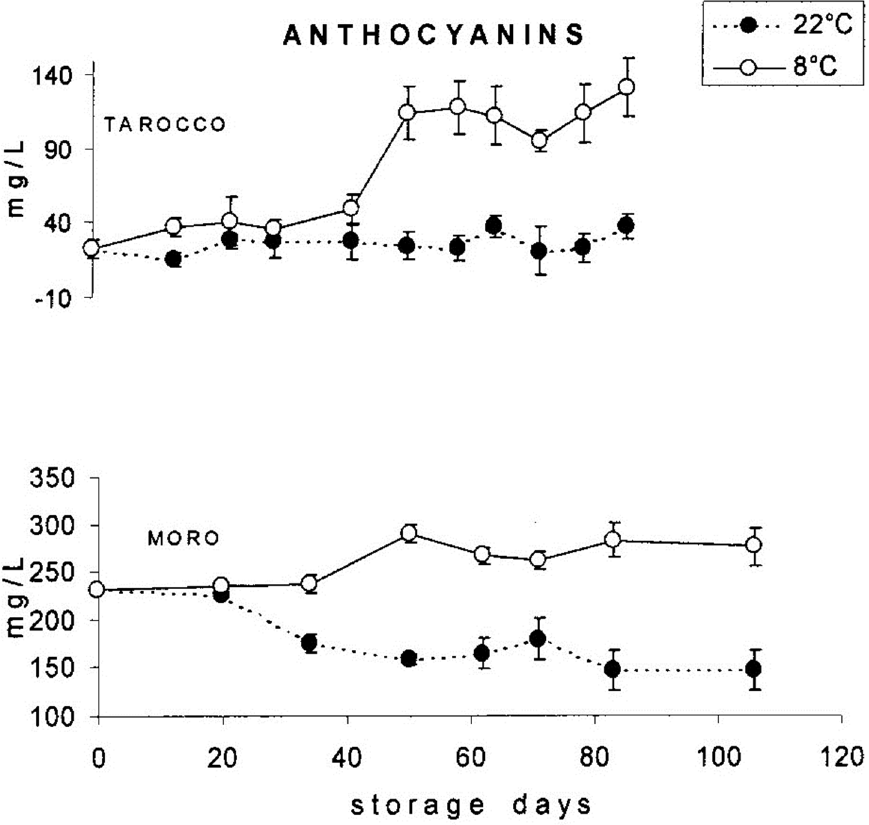
Figure 7. Change in anthocyanin content in the juices of ‘Tarocco’ and ‘Moro’ fruits stored at 8 and 22 °C, respectively. Reprinted from Rapisarda et al. [54].